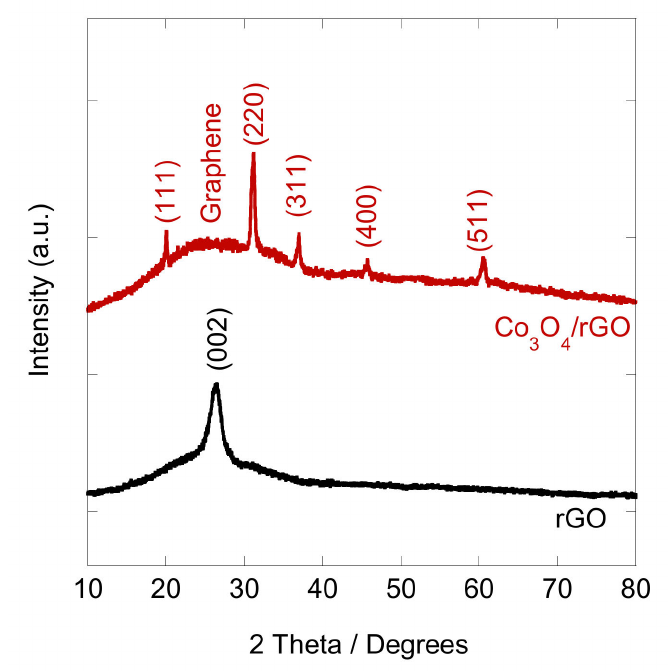
Figure 2. XRD patterns of rGO and Co 3 O 4 /rGO